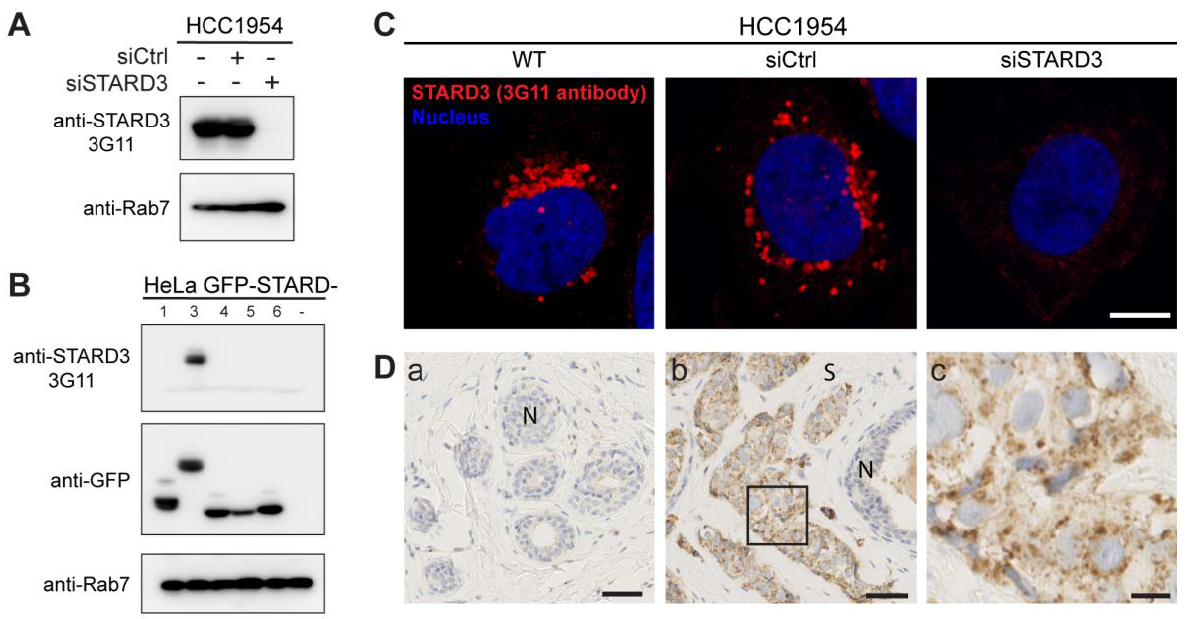
Figure 3. Generation of a specific anti-STARD3 antibody for immunohistochemistry. ( A ) Western blot analysis of STARD3 expression using the anti-STARD3 antibody 3G11 in HCC1954 cells (WT and transfected with control (siCtrl) and STARD3-targeting (siSTARD3)-siRNAs). Anti-Rab7 antibody was used as a loading control. ( B ) Western blot analysis of HeLa cells transiently expressing STARD1, STARD3, STARD4, STARD5, and STARD6 fused to GFP (GFP-STARD) using anti-STARD3 3G11 antibody. Anti-Rab7 antibody was used as a loading control. ( C ) HCC1954 cells (WT) and HCC1954 cells transfected with control siRNAs (siCtrl), and siRNAs targeting STARD3 (siSTARD3) were labeled with anti-STARD3 3G11 antibodies (red). Nuclei are stained blue. Scale bar: 10 µ m. ( D ) Immunohistochemistry on normal breast ( a ) and HER2+ breast tumor ( b ) sections using anti-STARD3 3G11 antibody. N marks the position of a normal duct. S marks the tumor stroma. The subpanel ( c ) is a higher magnification image (4.5 × ) of the area outlined in black in ( b ). Scale bar: 50 µ m ( a , b ) and 10 µ m ( c ). All the whole western blot figures can be found in the Supplementary materials.